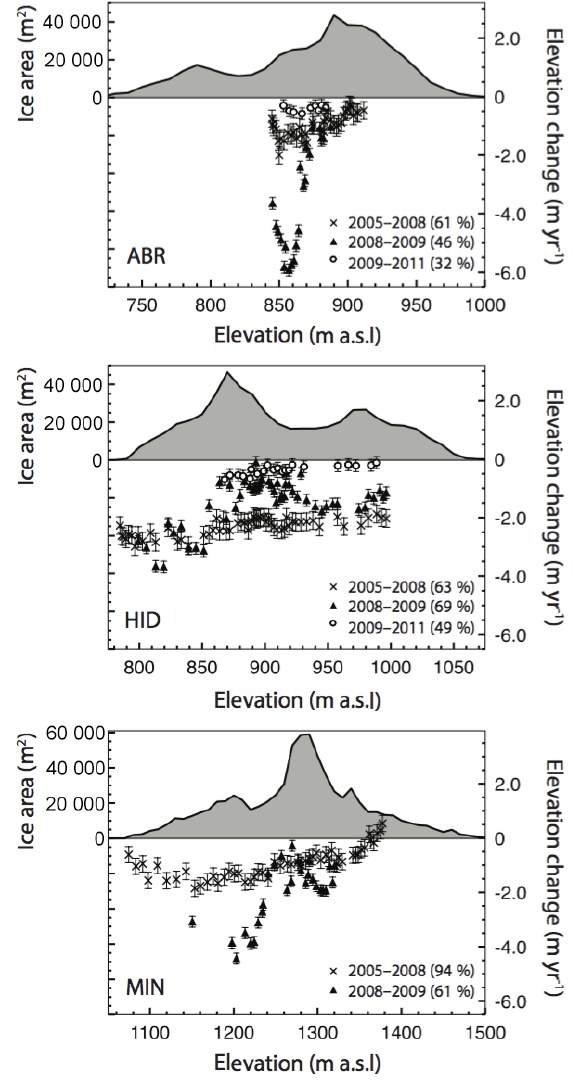
Figure 4. Hypsometry (filled line plots) and ice surface elevation change rates between 2005 and 2008 (crosses), and 2008 and 2009 (triangles) at Abraham (ABR), Hidden (HID), and Minaret (MIN) glaciers, and from 2009 to 2011 (circles) at Abraham and Hid- den glaciers. Error bars are 1 σ errors, determined empirically us- ing DEM vertical errors and errors in GPS receiver position. The percentage area surveyed (ratio of the total area of altitude bands containing at least one elevation change measurement to the total glacier area) are given for each time period, following the symbol